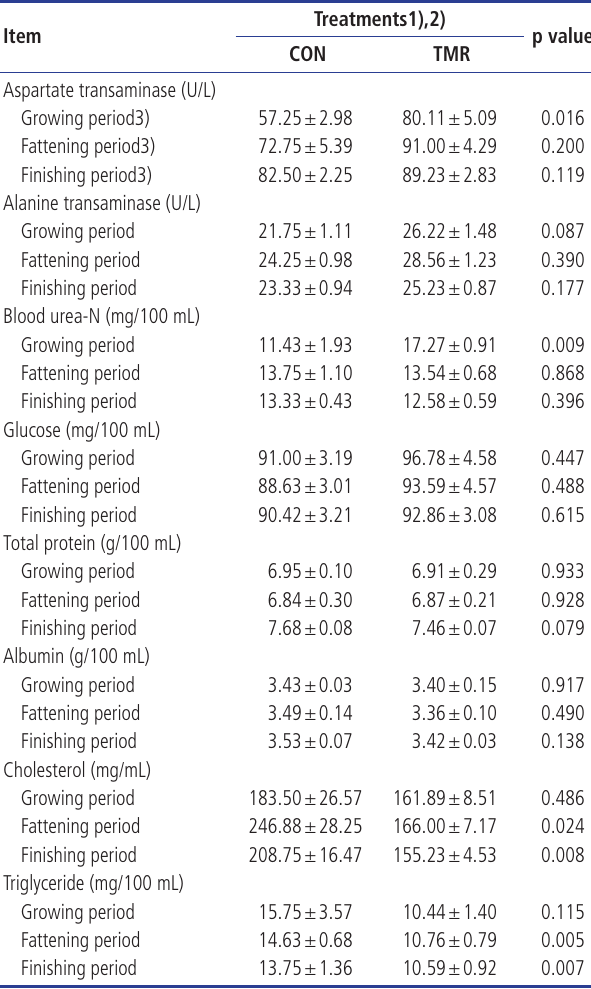
Table 4. Effects of feeding system on plasma biochemical components in Hanwoo